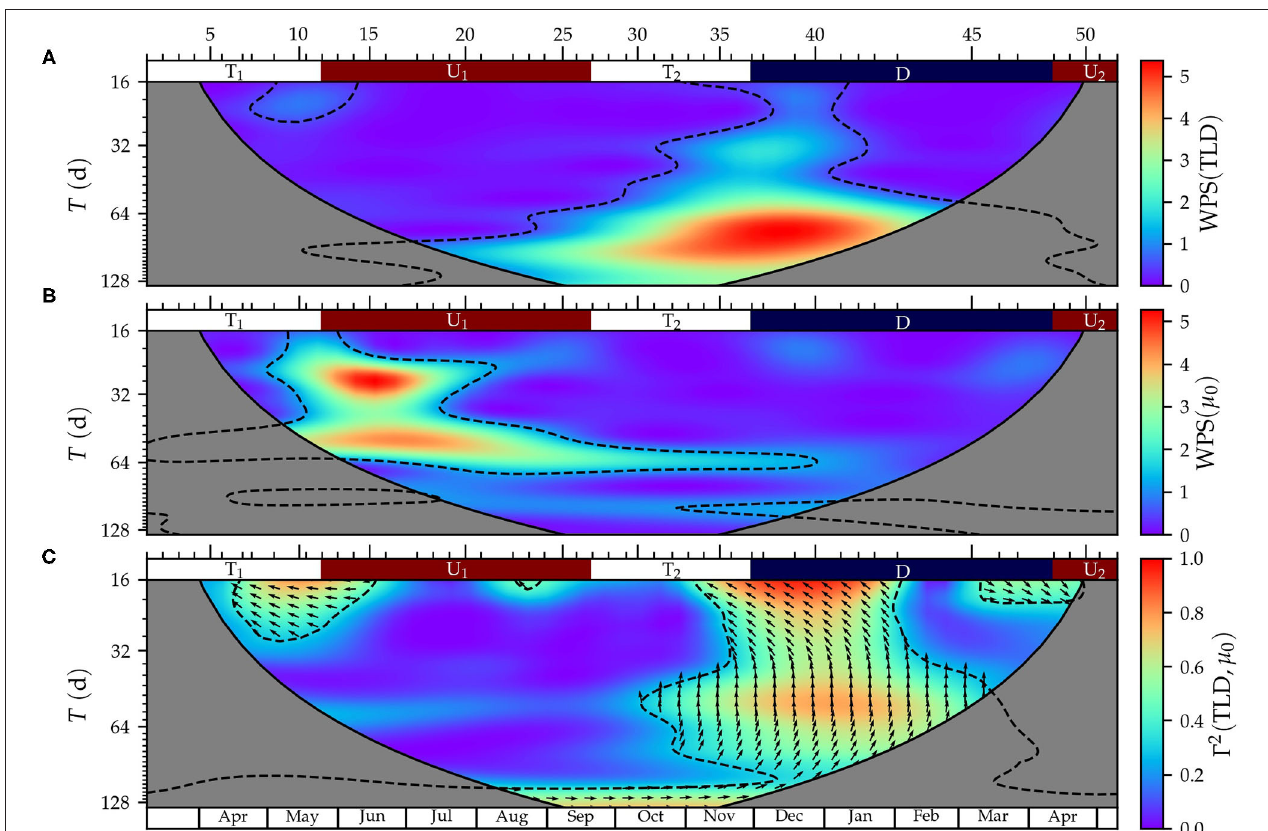
FIGURE 6 | Wavelet analysis of turbulent layer depth (TLD) and surface phytoplankton growth rates ( µ 0 ). (A) Wavelet power spectrum (WPS) of TLD, (B) WPS of µ 0 , and (C) wavelet coherence ( Ŵ 2 ) and phase difference ( δφ ) between TLD and µ 0 . The solid black line indicates the cone of influence inside which the edge effects have no influence. The black dashed lines denote the 0.05 significance regions. The arrows indicate δφ measured with respect to the horizontal axis in the anti-clockwise direction; e.g., → for δφ = 0 o and ↑ for δφ = 90 o . For simplicity, arrows are only plotted inside the regions where significance was higher than 0.05 and only one arrow is plotted every eight period-points. The ticks and numbers at the top axis indicate the sampling number and the colors, the periods for upwelling (U 1 and U 2 , in red), downwelling (D, in blue), and transition (T 1 and T 2 , in